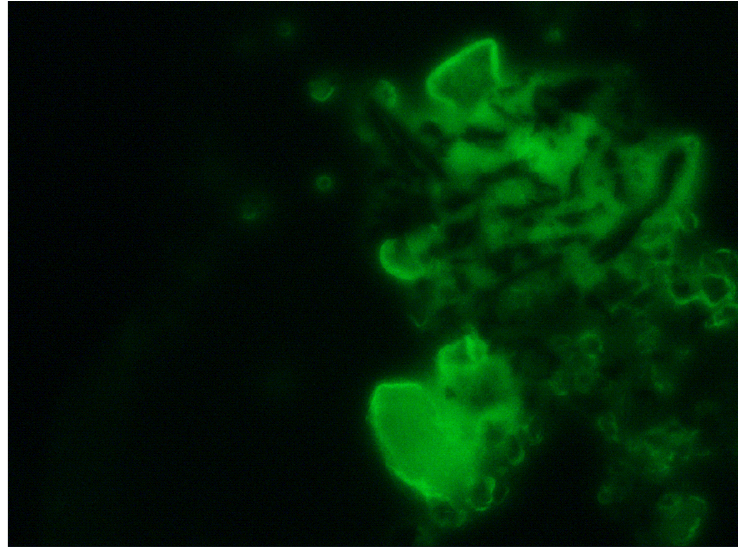
Figure 7. Fluorescence microscopic image of sandwich format (with IgE antigen concentration 294 IU·mL − 1 ) on the gold/glass microscope